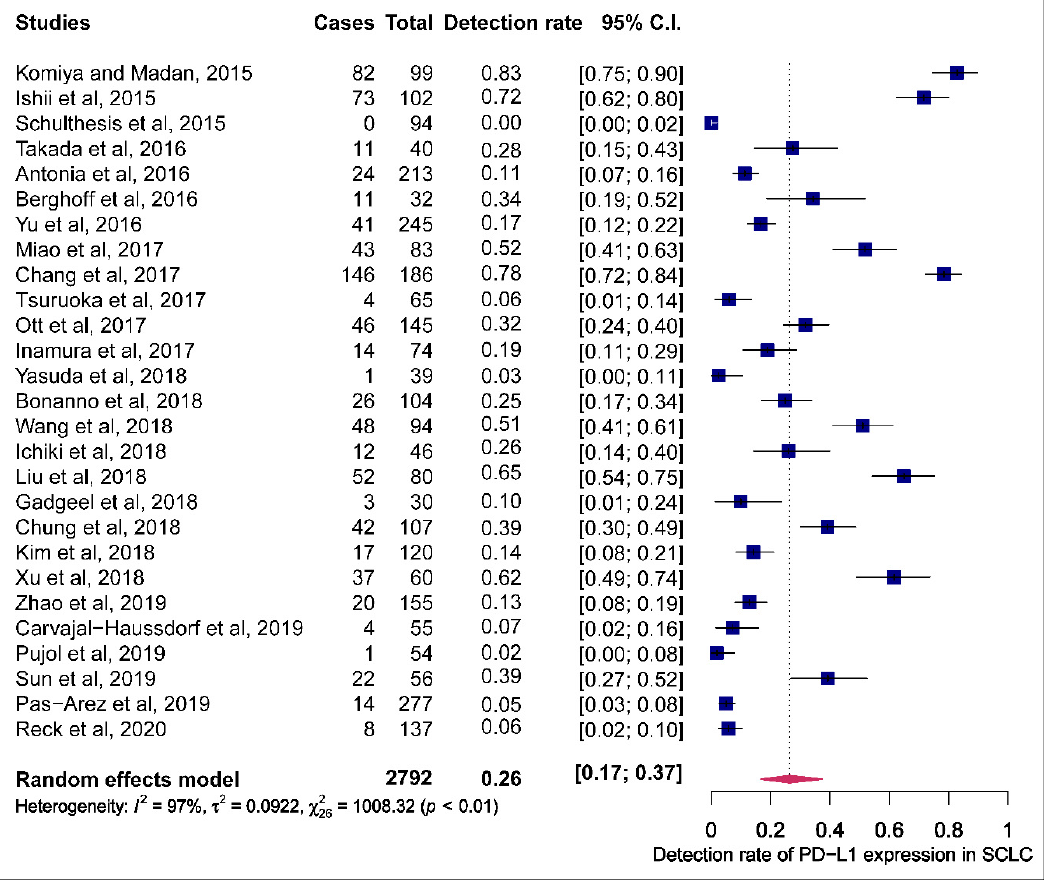
Figure 2. Forest plot of studies reporting the detection rate of programmed cell death ligand-1 (PD-L1) expression in small-cell lung cancer (SCLC). The PD-L1 detection rates and 95% CI of each study are represented with a horizontal line and the square area mirrors the point estimate of each study. A random-effect model was utilised.